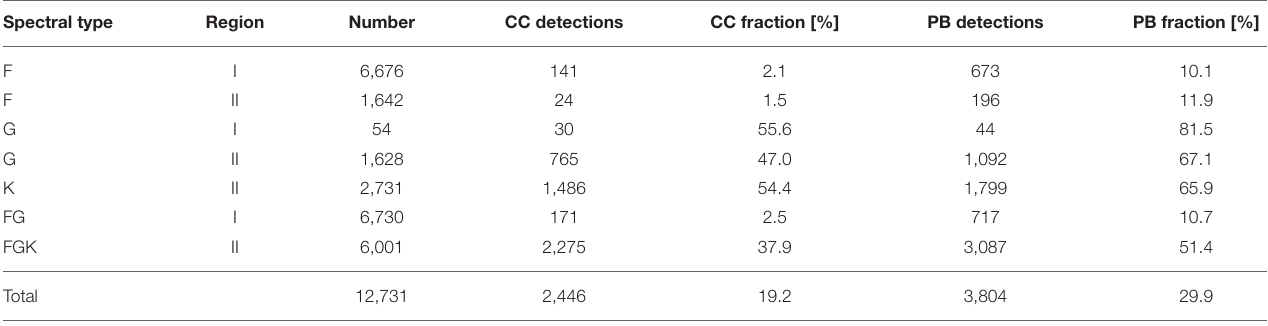
TABLE 1 | Predicted number of stars with significant frequency shifts for different spectral types and evolutionary stages. Spectral